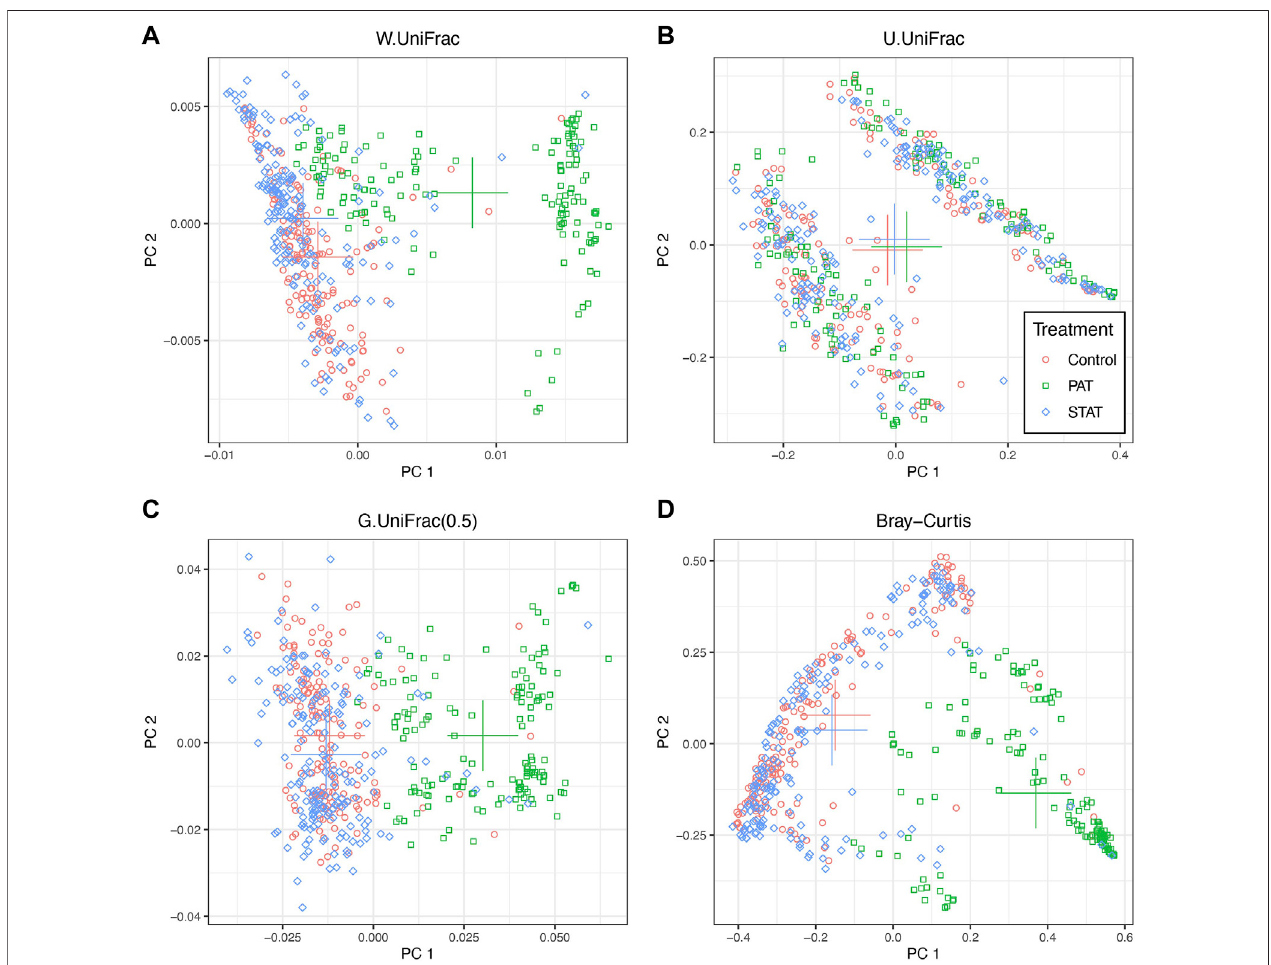
FIGURE 2 | The two-dimensional PCoA plots depicting microbiome composition for different antibiotic treatment groups under various dissimilarity measures. All 499 fecal samples are included in the plots. PAT, therapeutic-dose pulsed antibiotic exposure; STAT, sub-therapeutic continuous antibiotic exposure. The crosses denote the centroid of points of each treatment group. (A) W.UniFrac: weighted UniFrac distance; (B) U.UniFrac: unweighted UniFrac distance; (C) G.UniFrac(0.5): generalized UniFrac distance with tuning parameter a = 0.5; (D) Bray-Curtis: Bray-Curtis